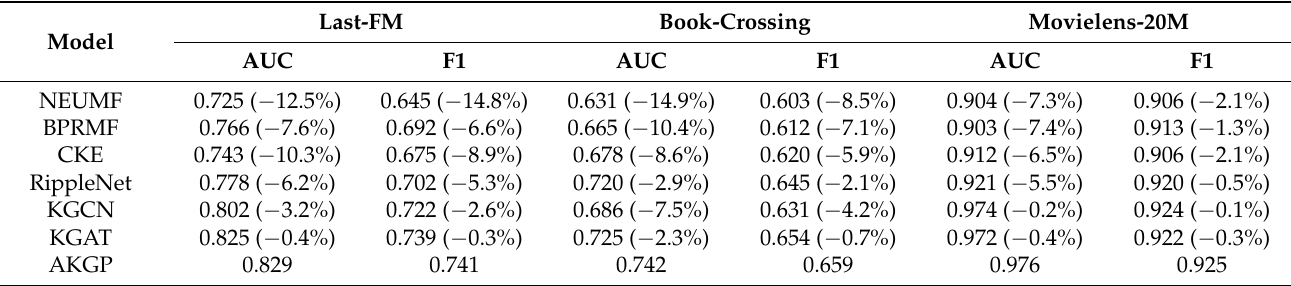
Table 3. Performance comparisons with baselines.